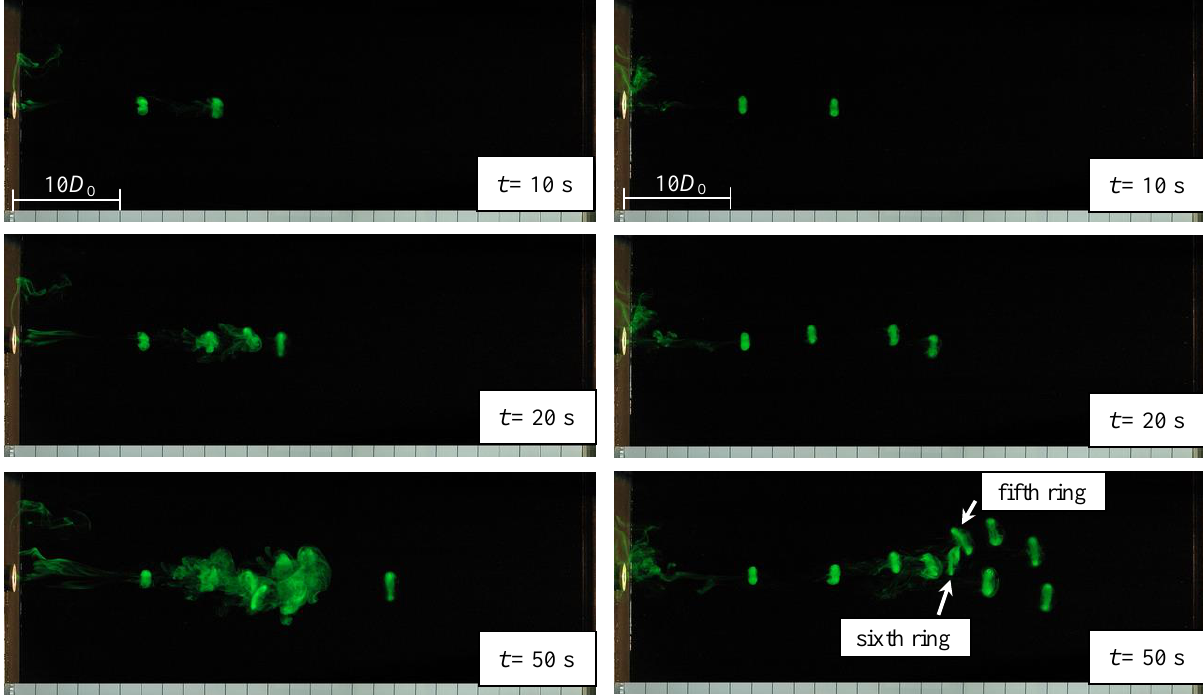
Fig. 4 Successive visualization of vortex rings with swirl (  = 0.2  rad/s) in case